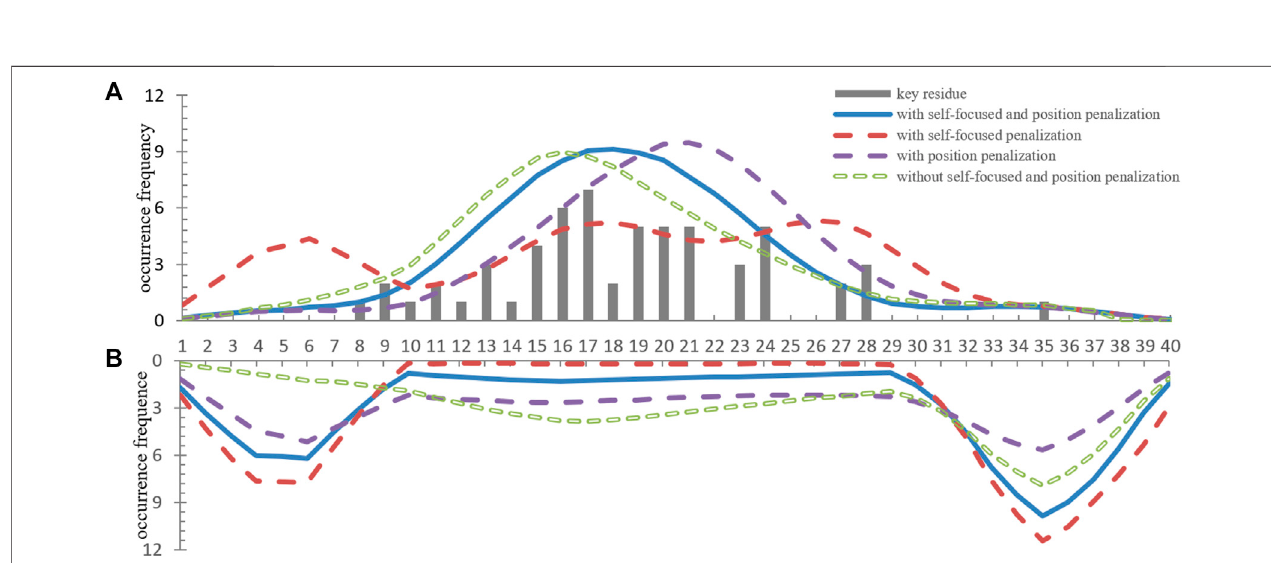
FIGURE 4 | (A) The position distribution of located subsequences for dimer fragments. (B) The position distribution of high weight subsequences for no-dimer